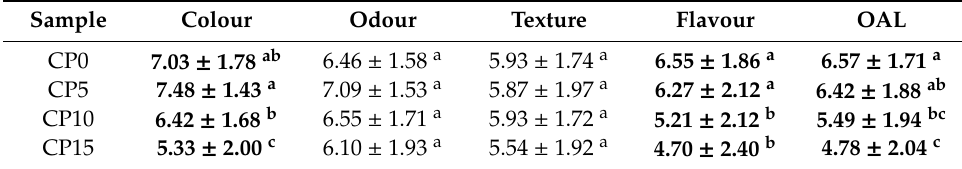
Table 6. Means and standard deviations of the liking variables across